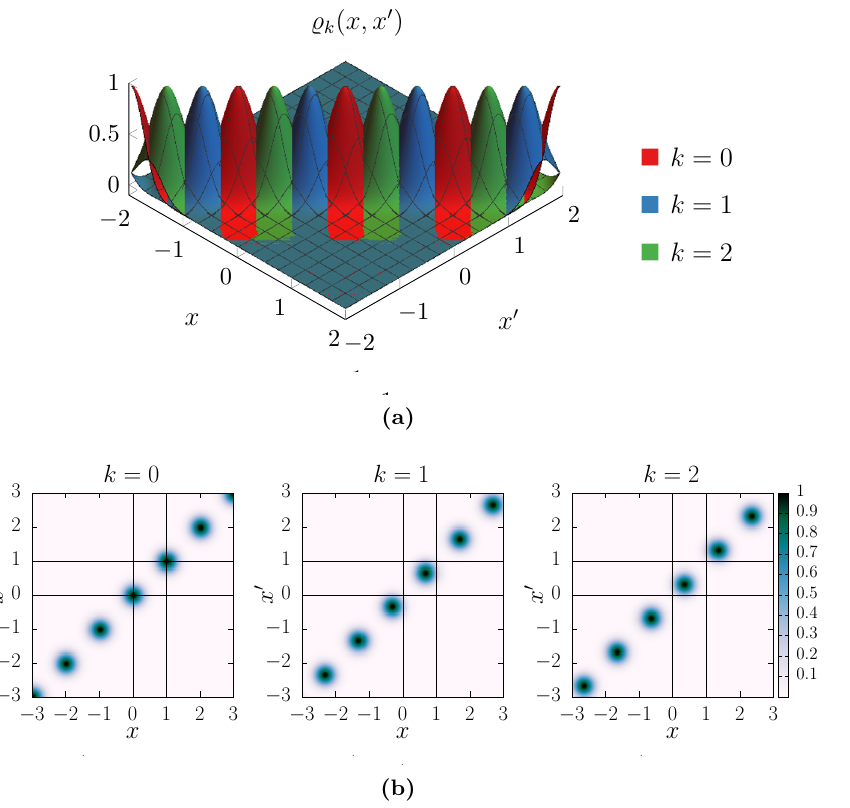
Figure 1. In (a), we represent the reduced density matrix % k ( x; x 0 ) obtained in (3.4) for k = 0 ; 1 ; 2 with (cid:18) = 3. In (b), we represent the distribution of these three reduced density matrices. Note that, since the particle moves on a torus, the coordinates x; x 0 are restricted to the interval [0 ; 1), as the lines in (b)